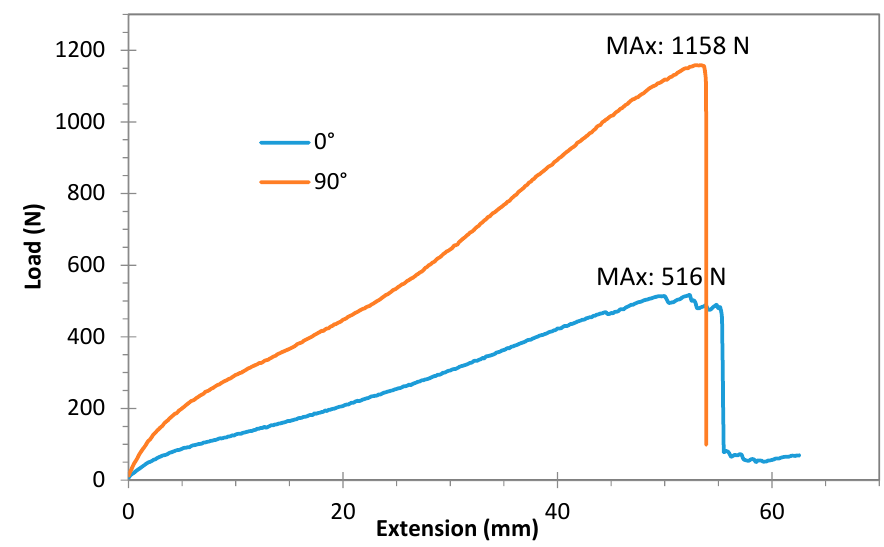
Figure 3. Barrateen fabric tensile behavior in main and transverse directions.